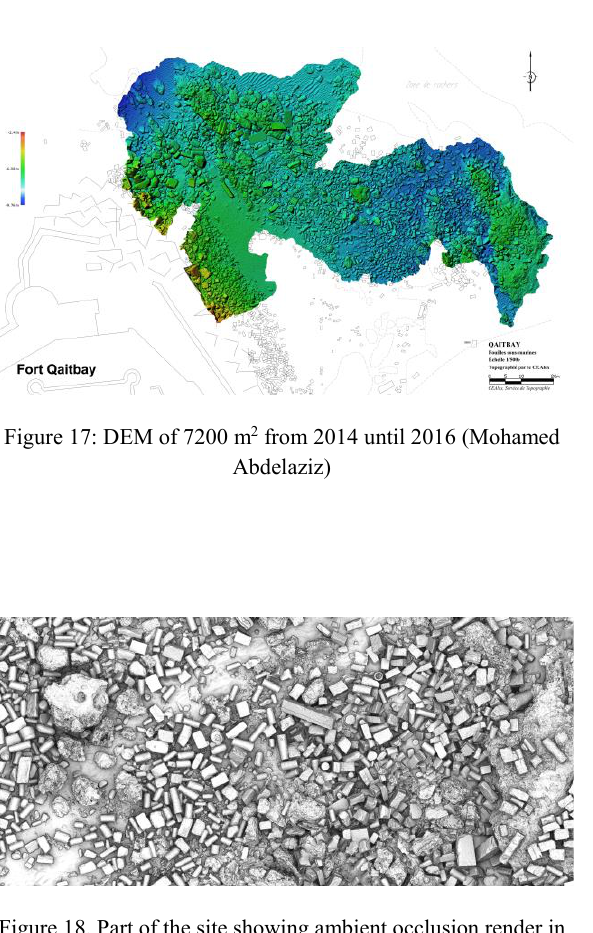
Figure 18. Part of the site showing ambient occlusion render in